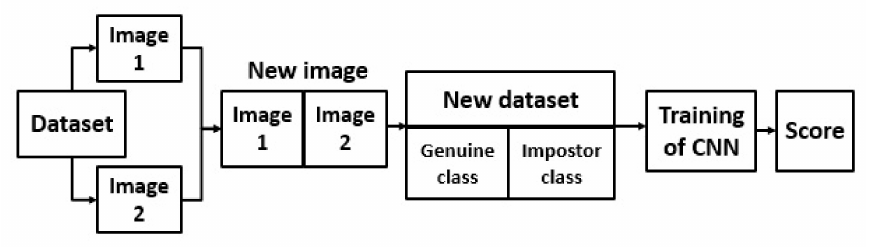
Figure 3. Scheme of the verification through identification